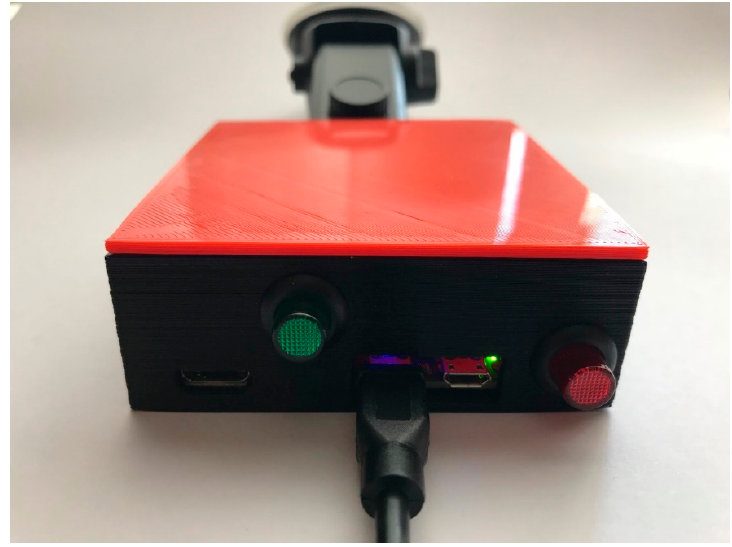
Figure 3. Finished prototype of the device.